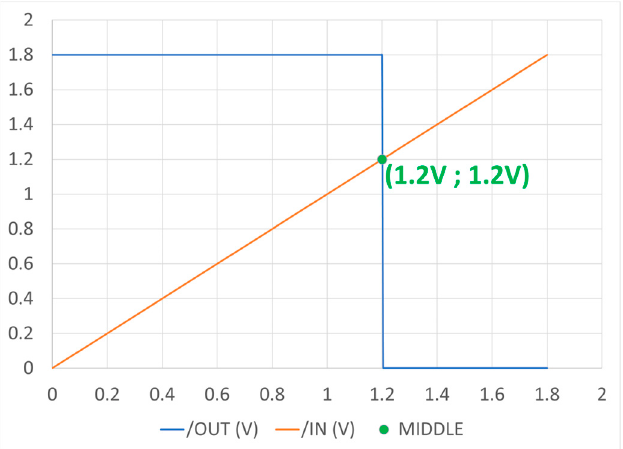
Figure 10. TIQ comparator post-layout simulation (DC).